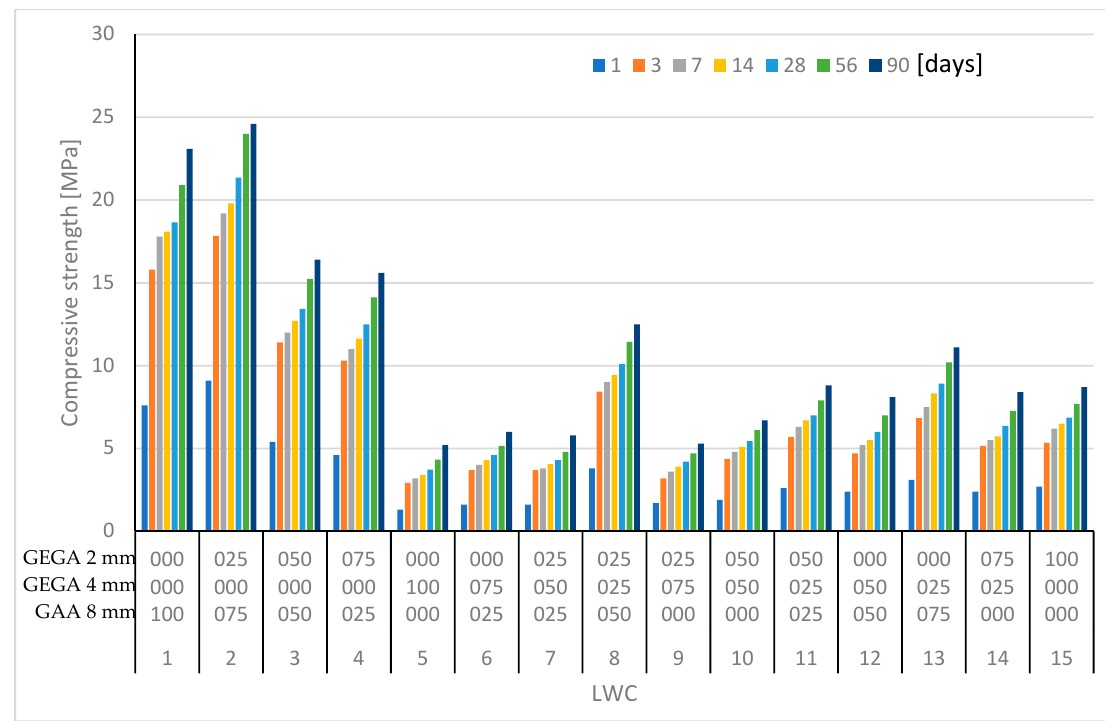
Figure 5. Compressive strength results for LWCs 1–15 at 1, 3, 7, 14, 28, 56, and 90 days.